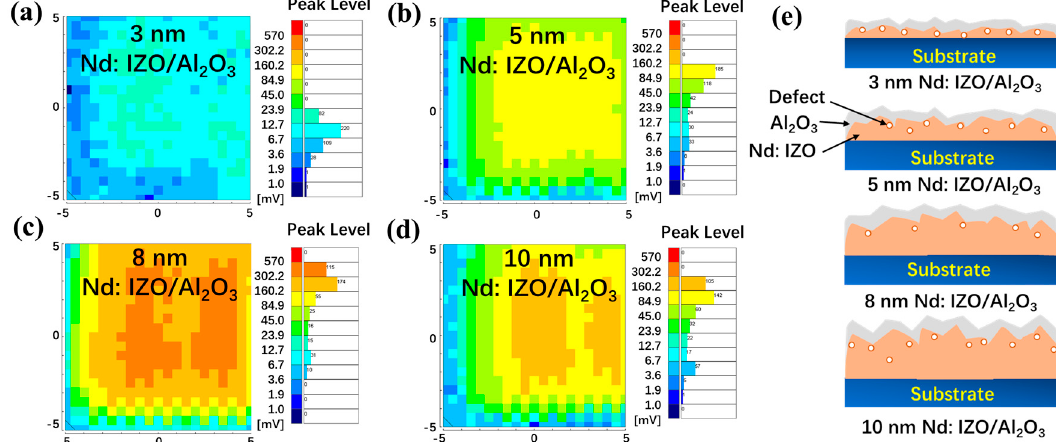
Figure 5. The microwave photo conductivity decay ( μ -PCD) peak value mapping scan results for the Nd:IZO/Al 2 O 3 stacks with an Nd:IZO thickness of ( a ) 3 nm, ( b ) 5 nm, ( c ) 8 nm, and ( d ) 10 nm;